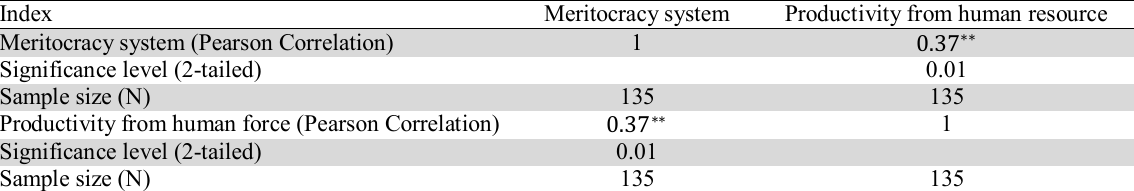
Result from Pearson's test about relationship between meritocracy system and productivity from human resource Index Meritocracy system Productivity from human resource Meritocracy system (Pearson Correlation) 1 Significance level (2-tailed) Sample size